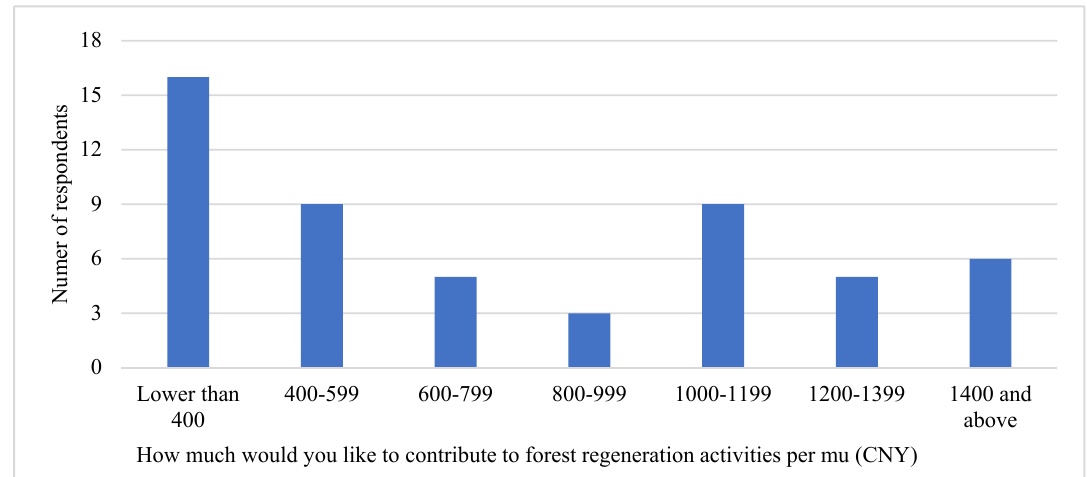
Figure 6. Number of intended contributions to forest regeneration of farmers. Note: Data is from the household structured questionnaire survey (n = 53). Mu is a commonly used measurement unit of area in rural China, and 1 mu = 667 m 2 = 1/15 ha.